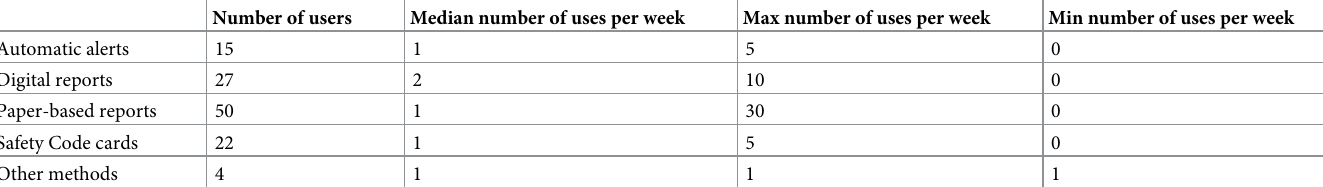
Table 3. Reported usage of the different CDS tools among survey participants. More than one CDS tool can be used by a single